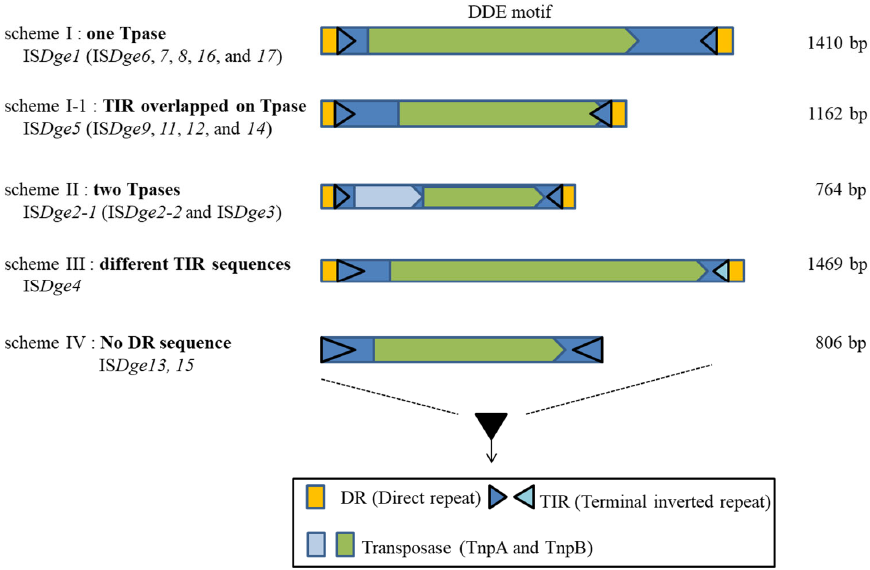
Figure 1. Illustration of four schemes of DDE ‐ type IS elements in Deinococcus geothermalis